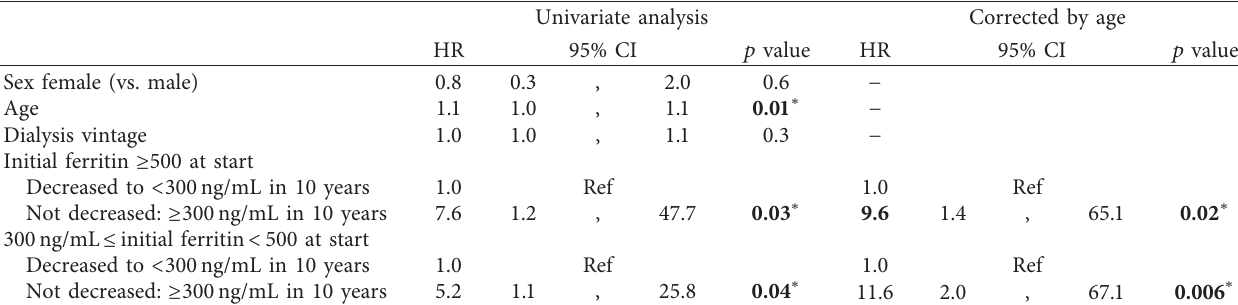
Table 3: Cox proportional hazards model for risk of death based on ferritin level < 300ng/mL versus ≥